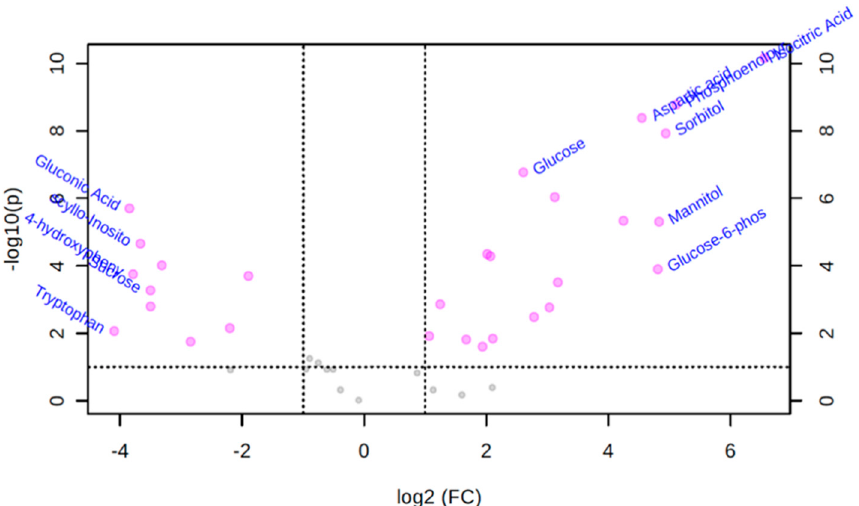
Figure 1. Important features selected by volcano plot analysis with a fold change threshold ( x ) of 2 and a t -test threshold ( y ) of 0.1. The red circles represent features above the threshold. Both fold changes and log transformed fold change for each significant compound are shown in the extended table of the volcano